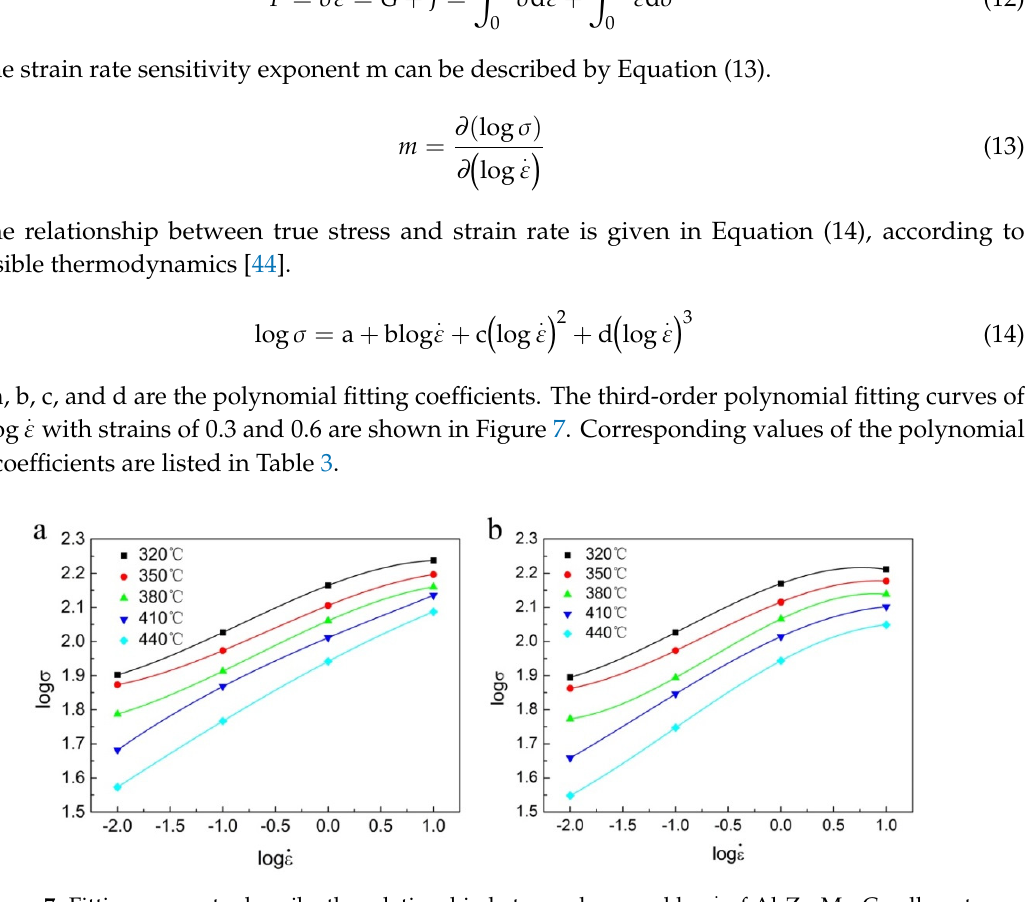
. ε of Al-Zn-Mg-Cu alloy at